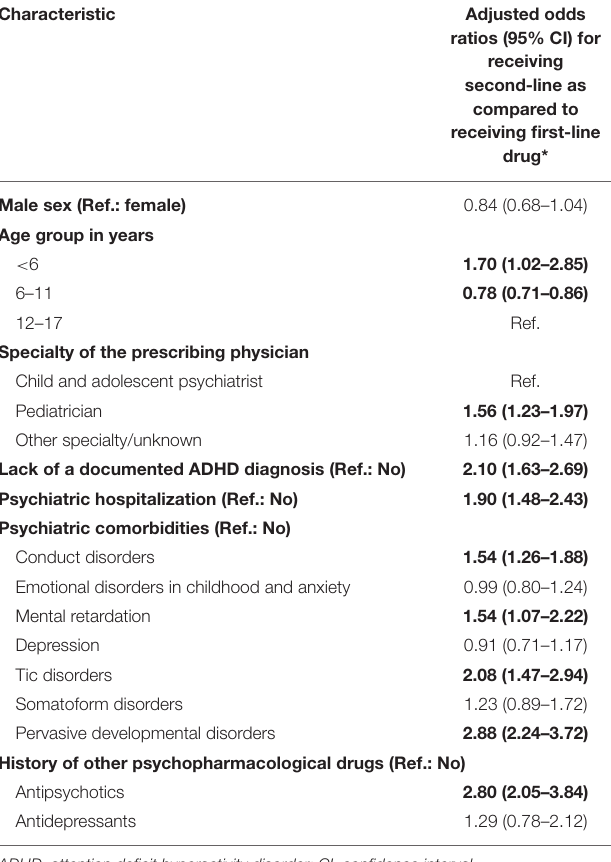
TABLE 2 | Adjusted odds ratios for characteristics associated with receiving a second-line drug among first-time users of ADHD medication. Characteristic Adjusted odds